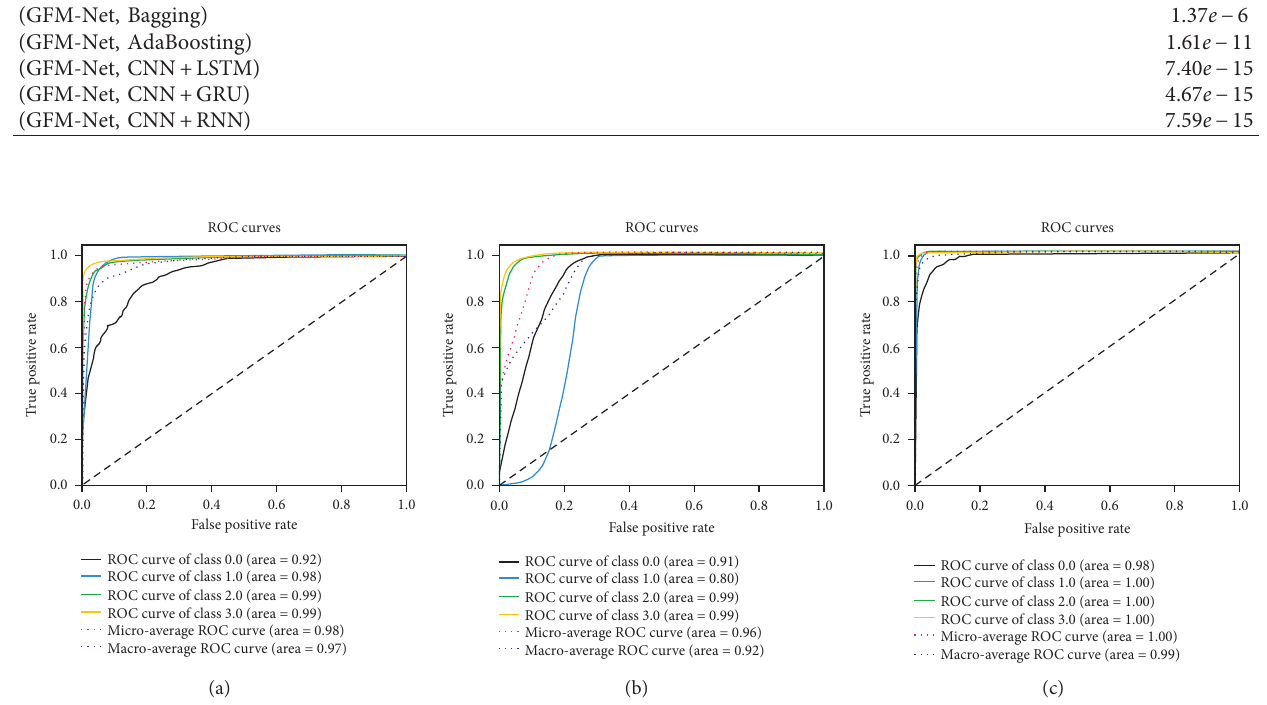
ROC curve of class 0.0 (area = 0.91) ROC curve of class 1.0 (area = 0.80) ROC curve of class 2.0 (area = 0.99) ROC curve of class 3.0 (area = 0.99) Micro-average ROC curve (area = 0.96) Macro-average ROC curve (area =